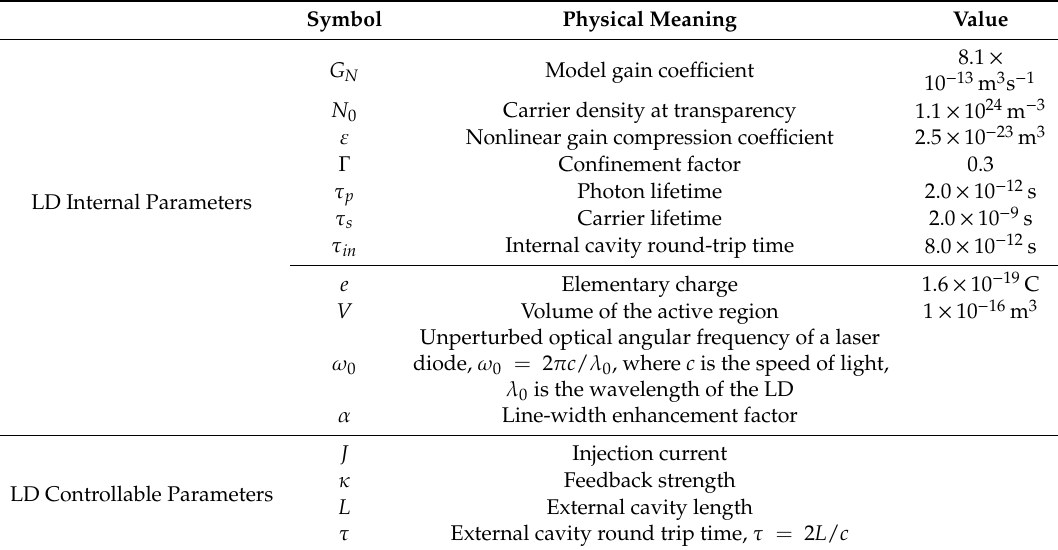
Table 1. Physical meanings of symbols in Lang and Kobayashi (L-K) equations